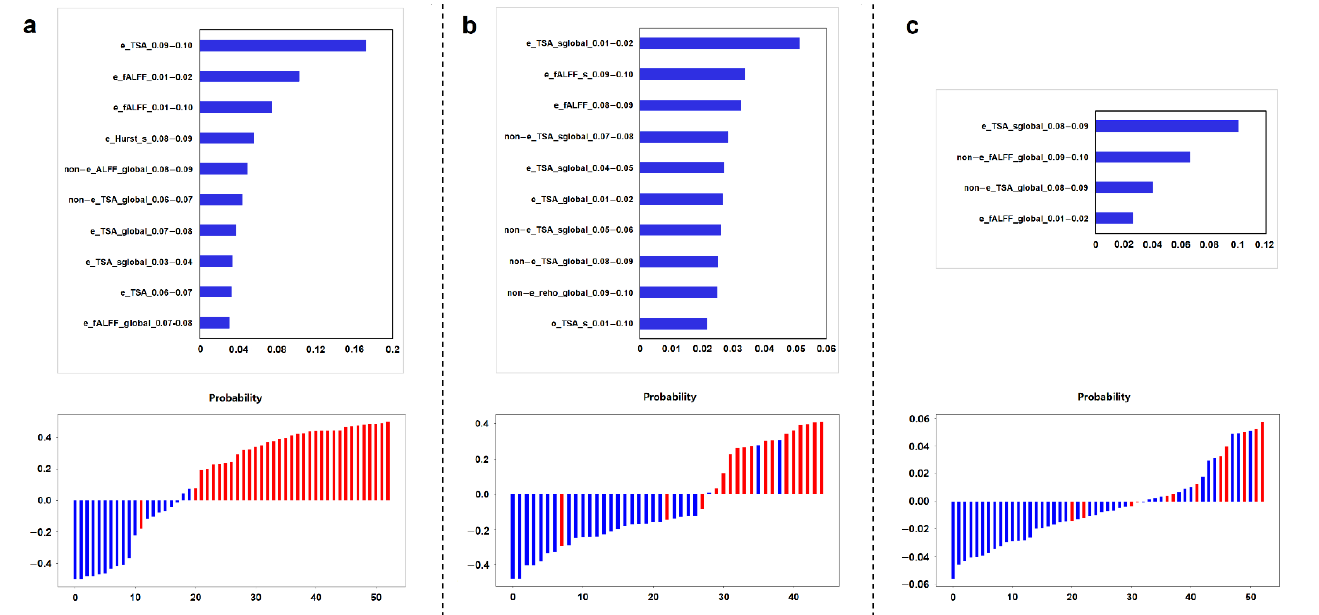
Figure 5. The first row shows the top 10, 10 and 4 importance ranking of RP-Rs-fMRIomics features in the ( a ) grading model, ( b ) IDH model and ( c ) survival model, respectively. The second row shows the bar plots of these three models in the validation cohort. The red bars with the predictive value >0 and the purple bars with the predictive value <0 indicate the successful classification of the corresponding prediction model, and vice versa.